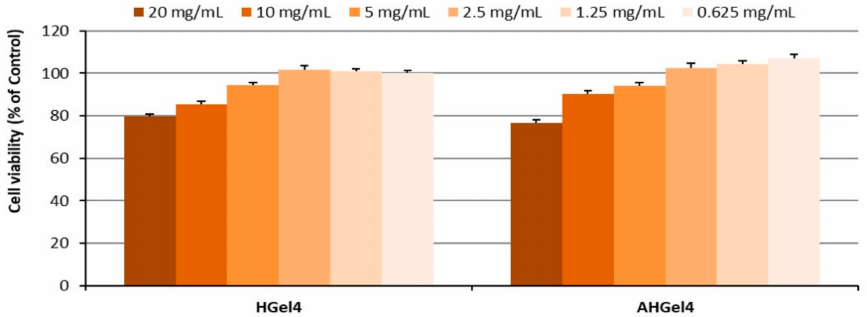
Figure 8. Viability of normal fibroblasts exposed to different concentrations of Gel4 and AHGel4 extract after 72 h. Experiments were performed in triplicate, and the viability of treated cells was expressed as a percentage of the viability of Control cells. Data plotted were expressed as means ± standard error of the